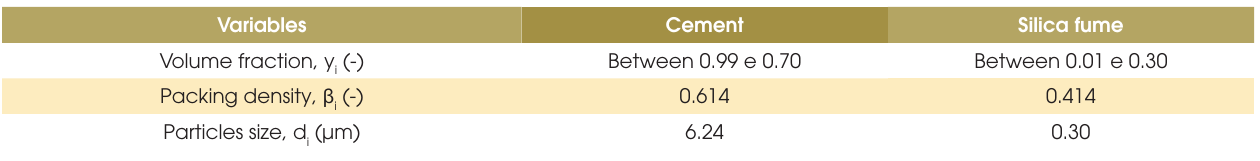
Table 2 – Input parameters used for calculation using the CPM model